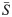
Numerical simulations reveal a transition between two regimes of antigenic diversity accumulation.(A) The percentage of new genes in the local parasite population at the end of a given simulation period (200 years) remains negligible when the reproductive number Rdiv for antigen-encoding new genes is lower than one. By contrast, this percentage increases rapidly above this threshold. Because the time interval over which we computed Rdiv = Gnew
Tnew concerns long transients, we evaluated the rate of generation of new genes Gnew as a mean over this interval (by averaging the values of N and S¯ every 180-day interval), and the lifespan Tnew, as an average for all the new genes that invaded during this time (with this interval placing an upper bound on individual lifespans). (A, B) Each point represents a simulation with different combinations of parameters and assumptions (including variation in rules of within-host dynamics, in strength of the trade-off between transmissibility and duration of infection, and in values and seasonality of the transmission rates, Table A and Table B in S1 Text). (B) The percentage of new genes also exhibits the threshold behavior with the entomological inoculation rate (EIR, the number of infectious bites per person per year).